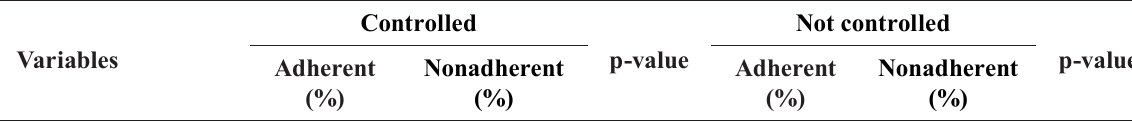
TABLE II - Prevalence of self-reported drug adherence in industry workers with controlled and uncontrolled hypertension and/ or diabetes mellitus, 2017 to